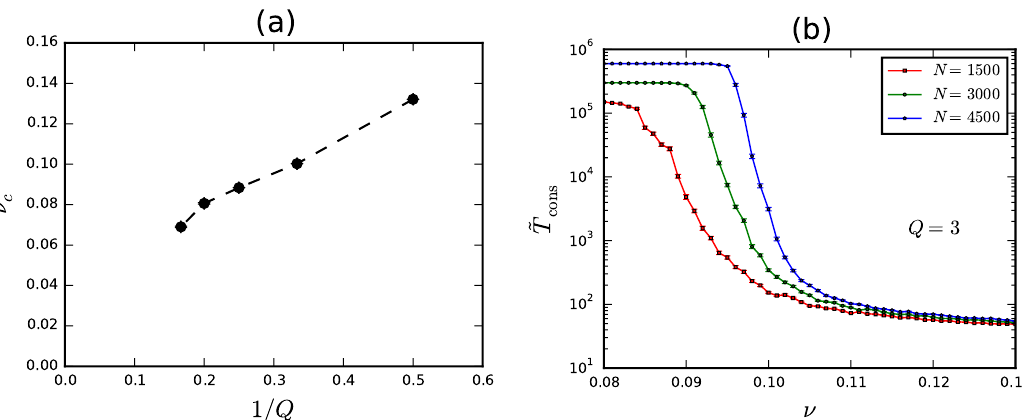
Figure 10. ( a ) Dependence of ν c upon the number Q of communities; ( b ) Bounded time to consensus from simulations in the PPM with Q =